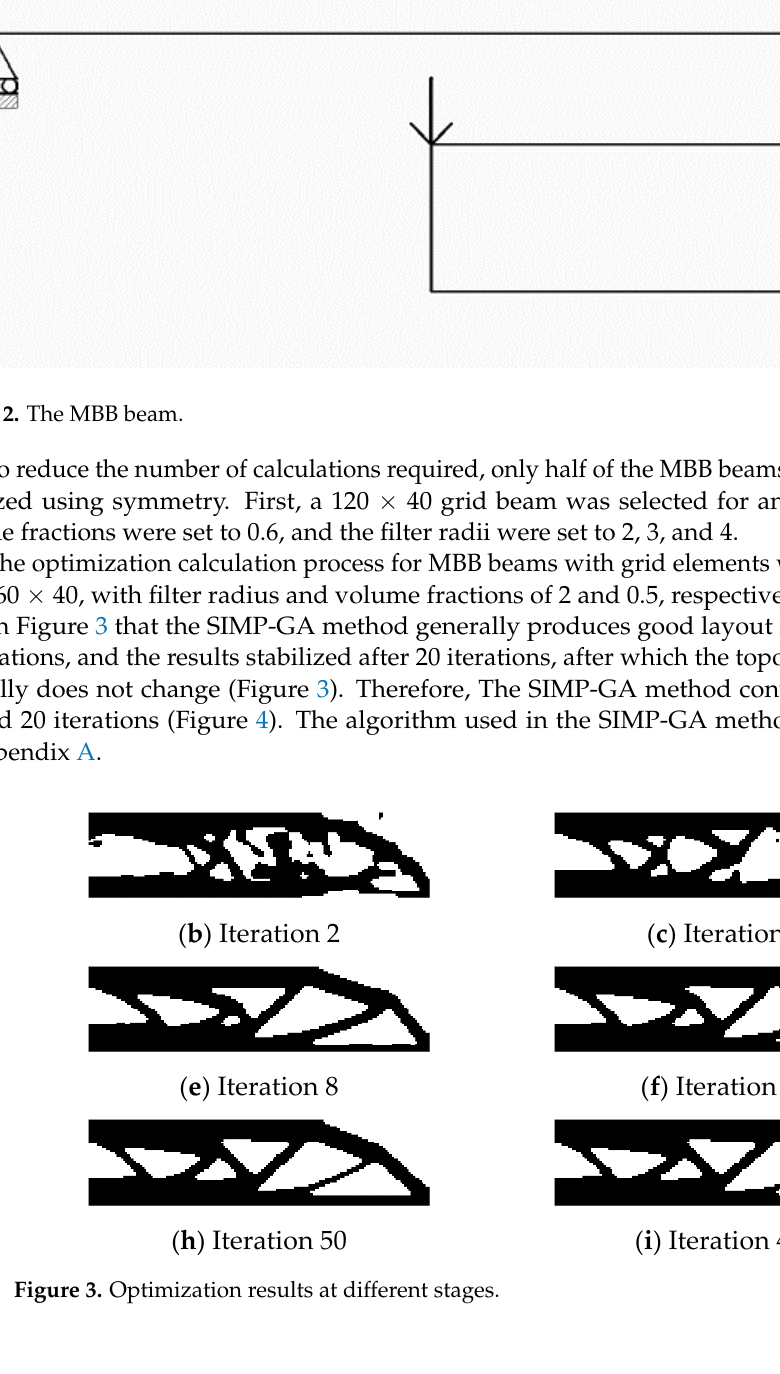
( i ) Iteration 400 Figure 3. Optimization results at different stages. Figure 4. Variation of objective function with iteration steps.